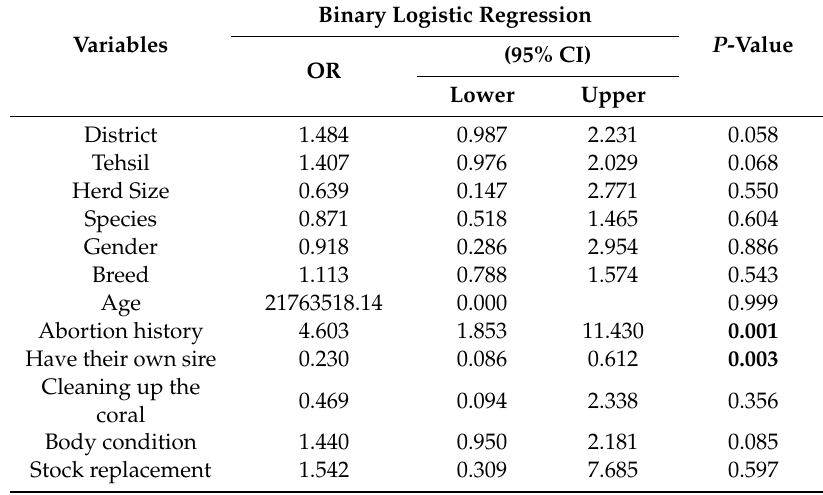
Table4. Finalmodelwithassociatedriskfactorsforanimalbrucellosis-binarylogisticregressionanalysis.